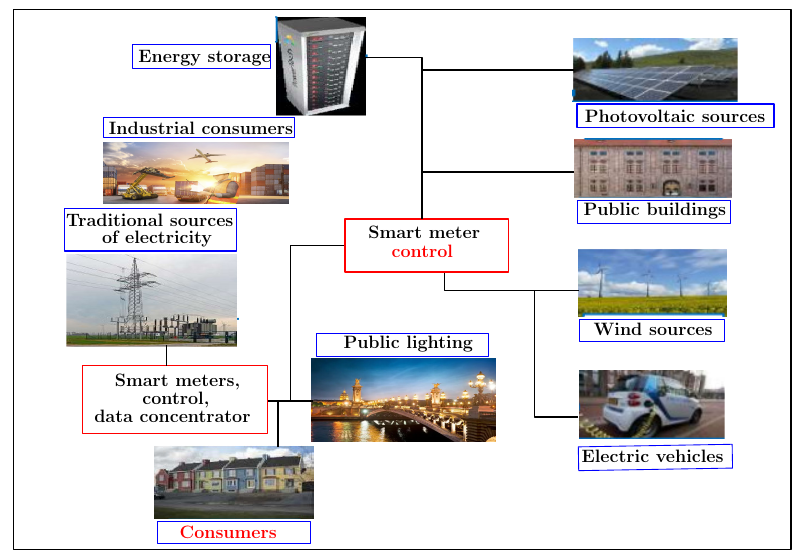
Figure 1. The smart grid context: VERTPOM